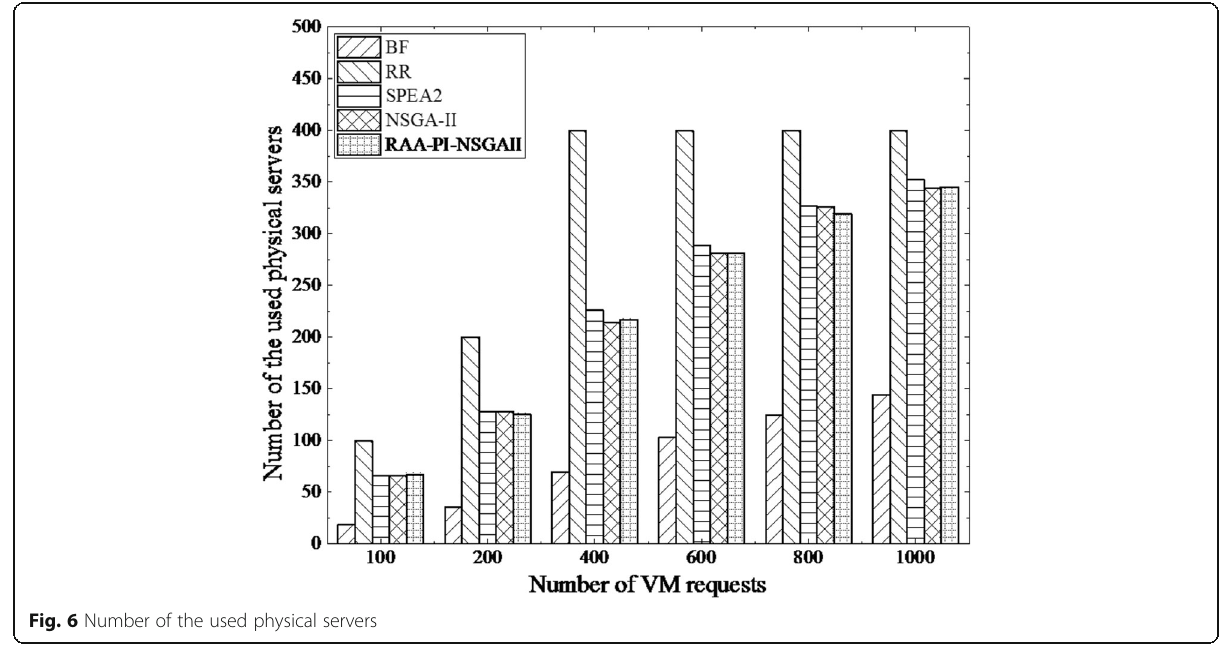
Fig. 6 Number of the used physical servers